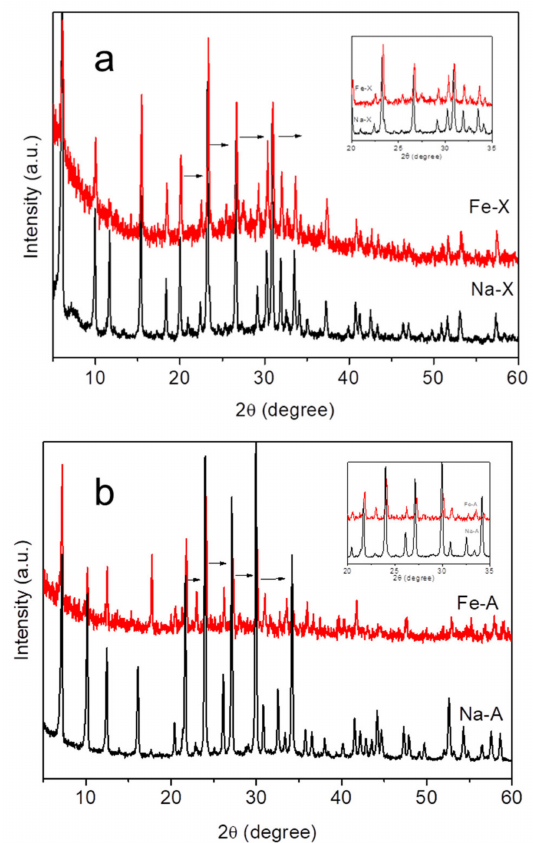
Figure 1. Section ( a ): powder XRD patterns of Na-X and Fe-X zeolites; section ( b ): powder XRD patterns of Na-A and Fe-A